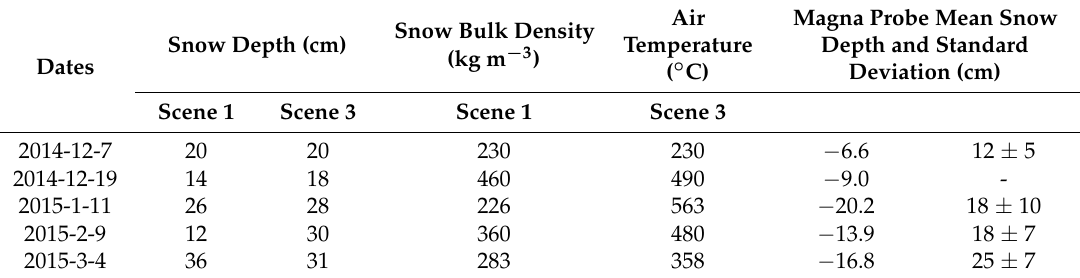
Figure 1. Snow pits measurements in the vicinity of Scene 1 ( left ) and Scene 3 ( right ) performed at each visit. Dark blue lines are the snow layer density. Scene 2 was not considered in this study. Table 1. Snow and air temperature measurements during each visit. “-” means no data. Note that missing data are related to technical issues with instruments.